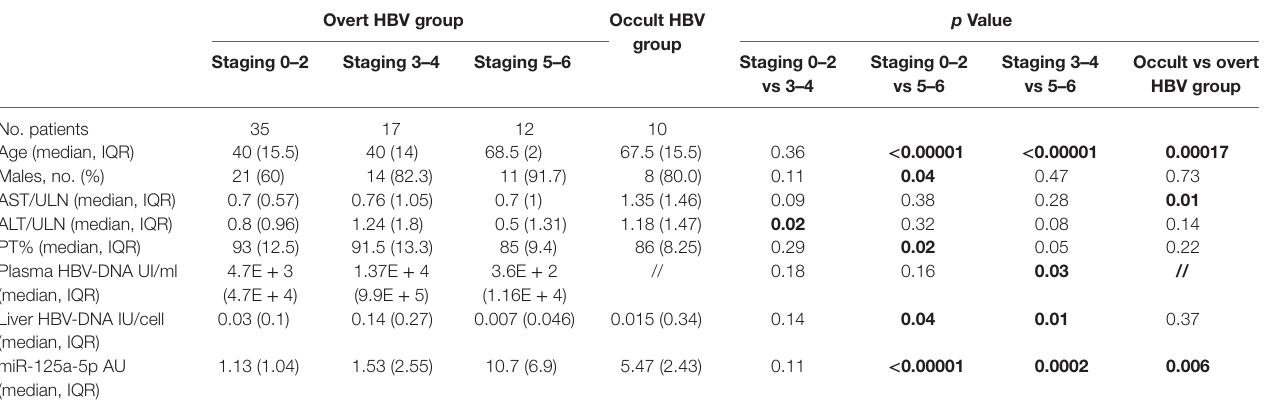
TaBle 2 | Characteristics of HBV patients stratified according to liver fibrosis.